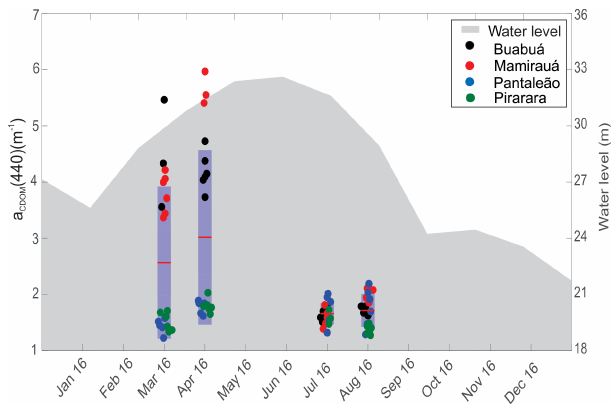
Figure 2. Seasonal box plot of a CDOM ( 440 ) (m − 1 ) and the water level (m) of the Mamirauá channel in 2016. The red lines are the mean a CDOM ( 440 ) , each dot represents the a CDOM ( 440 ) value at each sample station, and the blue boxes represent the interval be- tween the first and third quartile. The water level was measured at Mamirauá channel (Mamirauá Sustainable Development Institute,